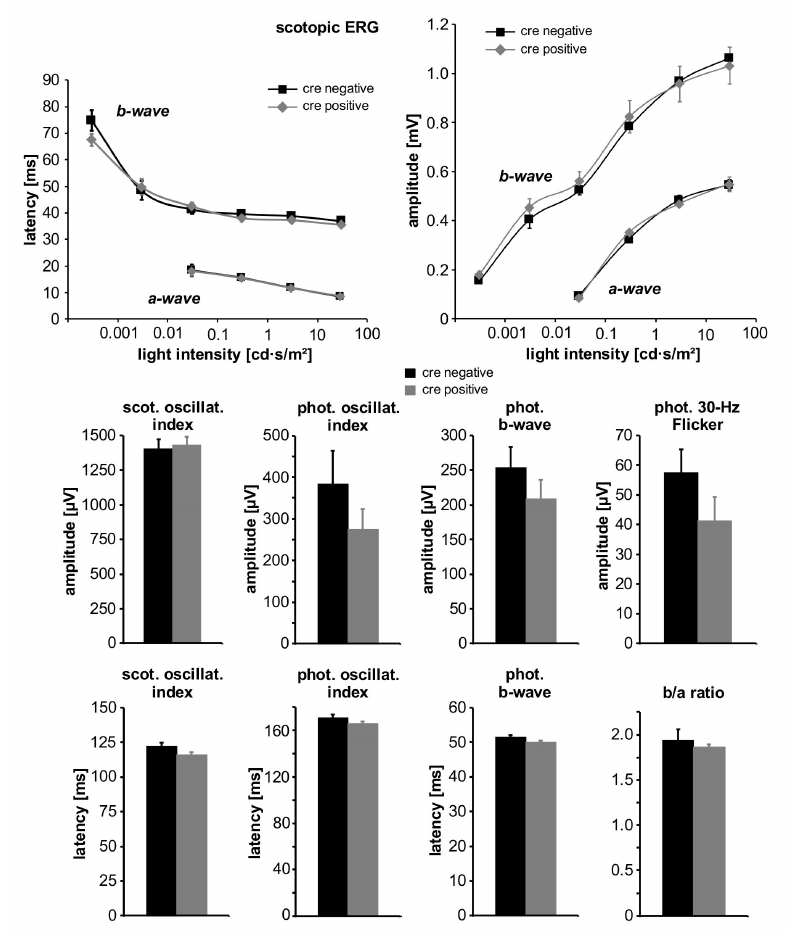
Figure 8. Values of different ERG parameters obtained in Cre-positive (knock-outs) and Cre-negative (con- trols) WWC1 − / − WWC2 − / − mice. On top, latencies and amplitudes in scotopic ERG are shown depending on intensity of light stimulus. Below, amplitudes and latencies of scotopic and photopic oscillatory index, photopic b-wave, photopic 30-Hz Flicker ERG, and scotopic b/a ratio are shown as